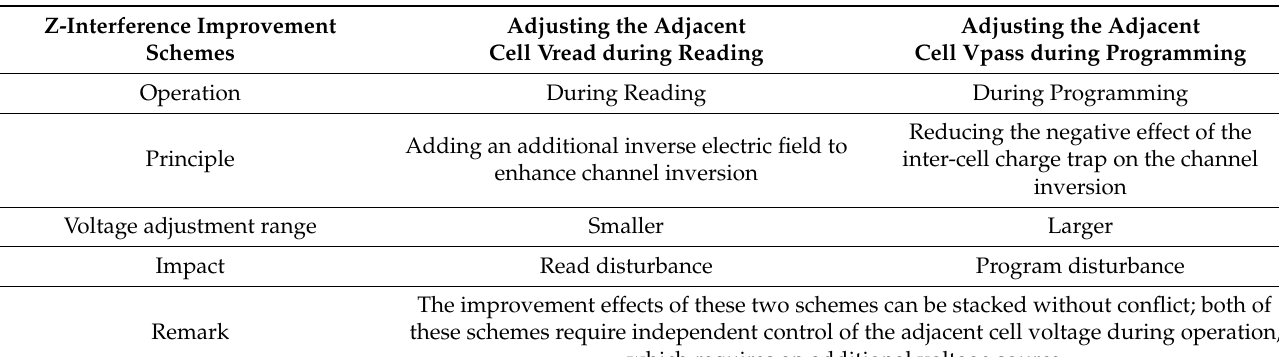
Table 1. Comparison of the schemes when adjusting the adjacent cell Vread and